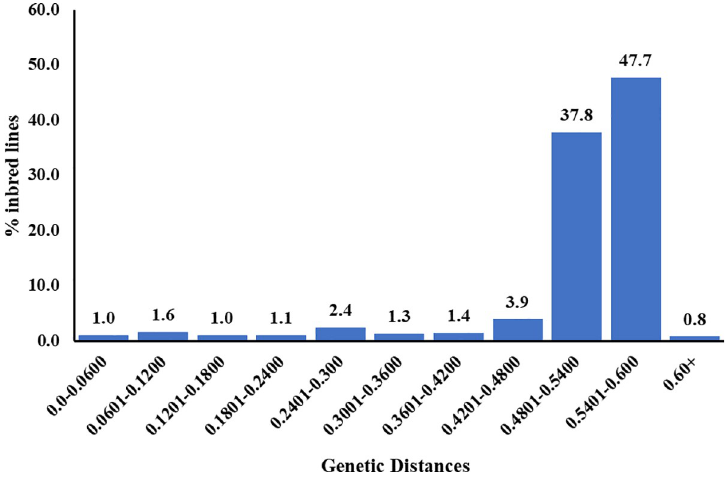
Fig 2. Frequency distribution of pairwise genetic distances among the inbred lines estimated using the Nei’s method using 1691 SNP markers.